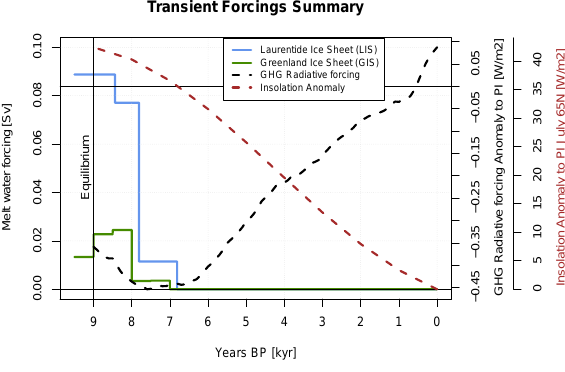
(Table 1: 9kOGx1, 9kOGx2, 9kOGx4). In these